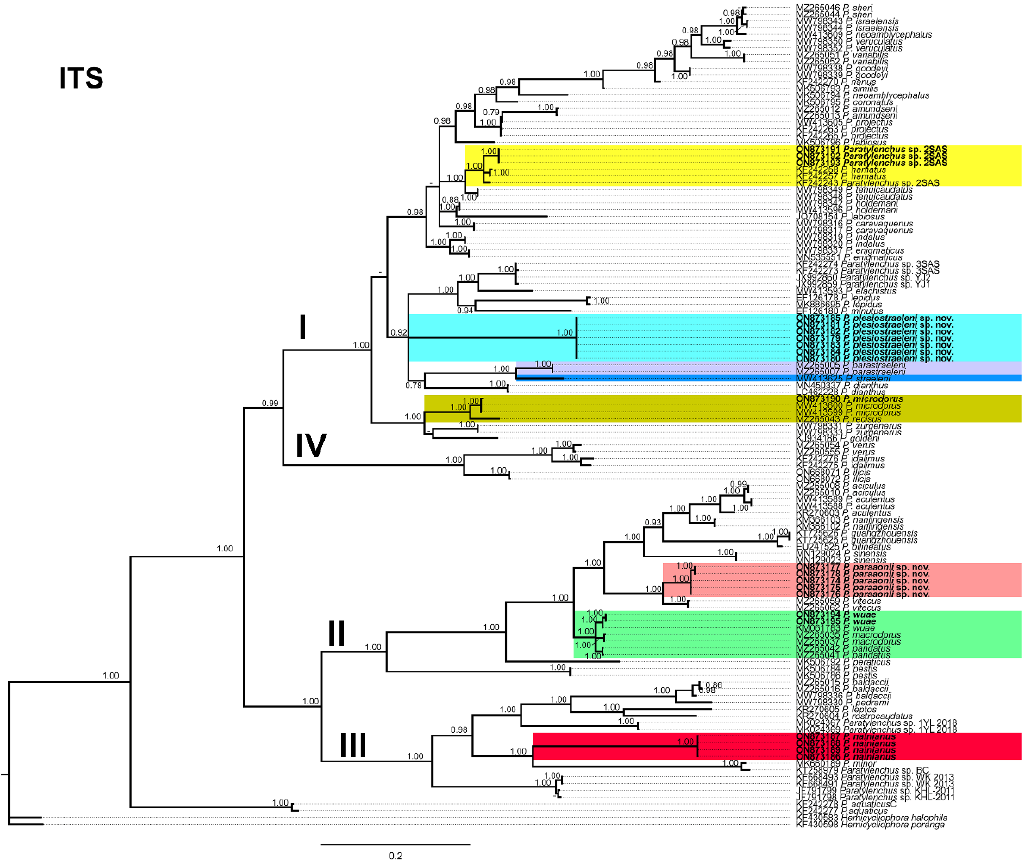
Figure 15. Phylogenetic relationships within the genus Paratylenchus . Bayesian 50% majority rule consensus tree as completed from ITS rRNA sequence alignment under the general time-reversible model with invariable sites and gamma distribution model (GTR + I + G). Posterior probabilities of more than 0.70 are given for appropriate clades. Newly obtained sequences in this study are shown in bold. The scale bar indicates expected changes per site, and the colored boxes indicate the clade association of new Paratylenchus species sequenced in this study.